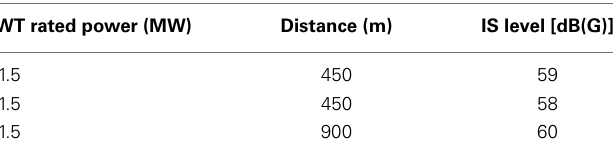
Table 4 | Indoor infrasound measured at three homes at two different distances to 1.5MW turbines .